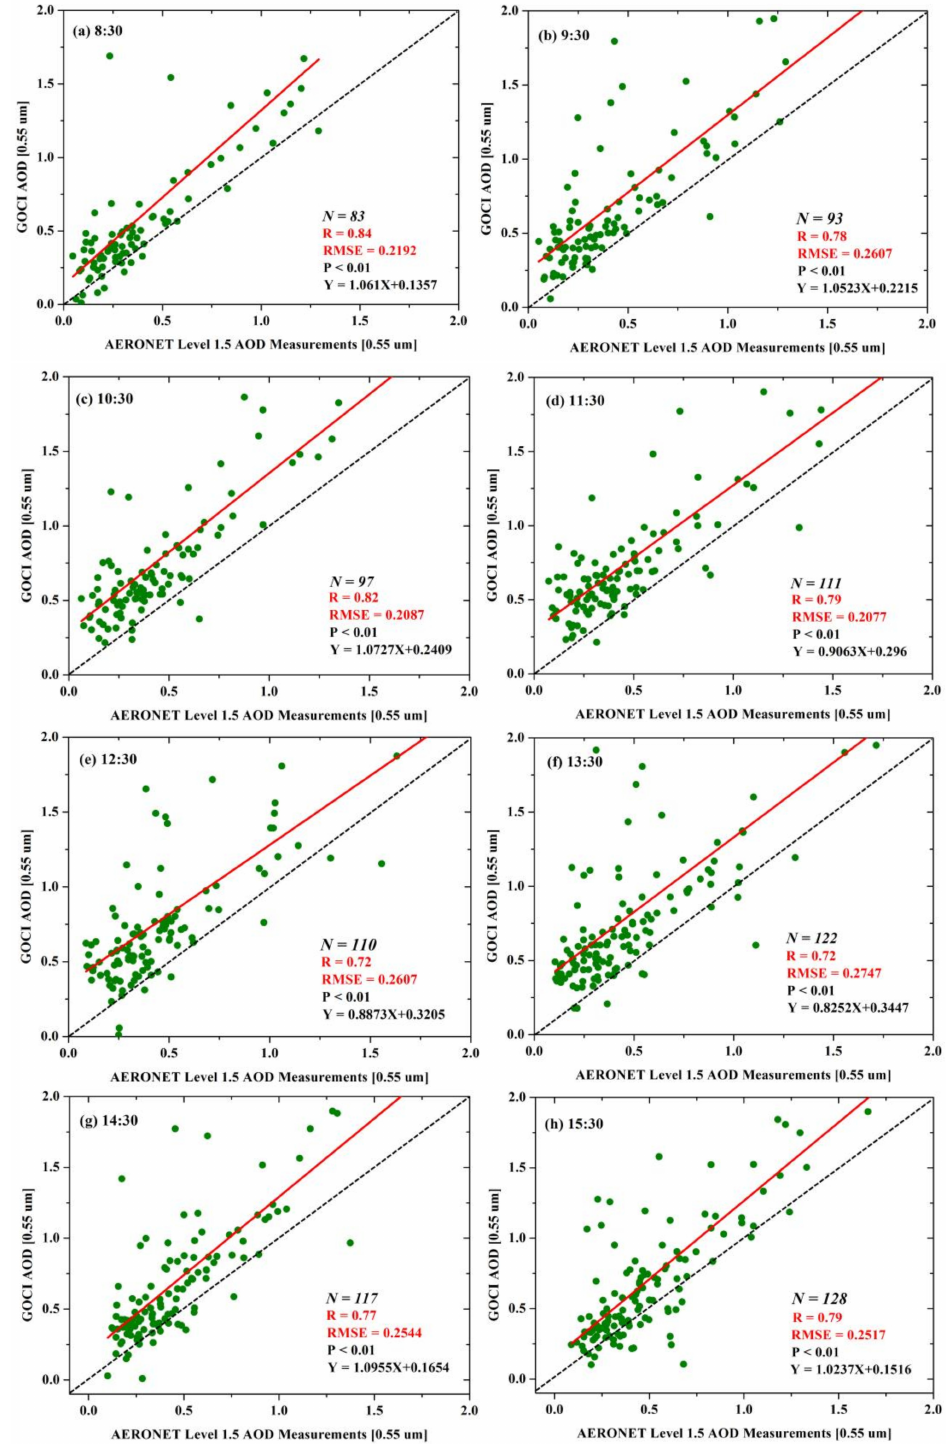
Figure 6. Comparison between AOD retrieved from GOCI images and Taihu station measurements (The upper left corner indicates the sensor observation time, N is the number. ( a – h ) are the verification results of 8:30 a.m.–15:30 p.m.,